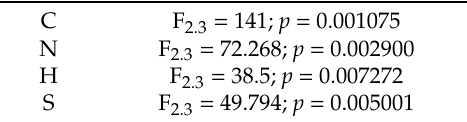
Table 4. Statistical evaluation—variance analysis ANOVA.